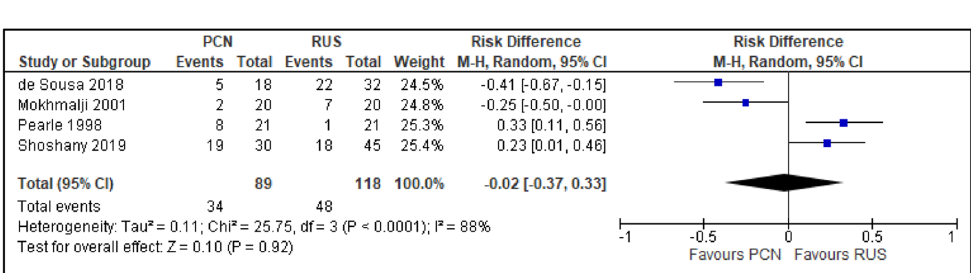
Figure 18. Comparison between PCN and RUS for outcome of analgesics